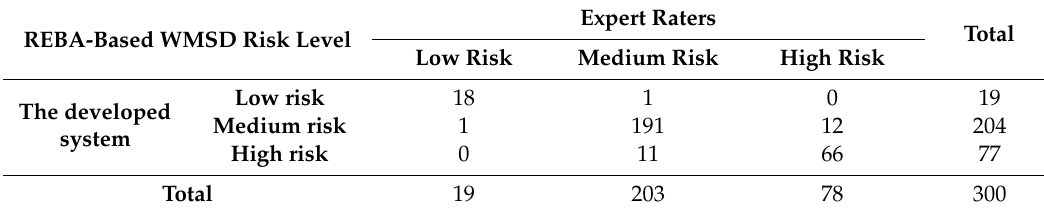
Table 3. REBA-based WMSDs risk level classification agreement between the developed system and the expert raters.